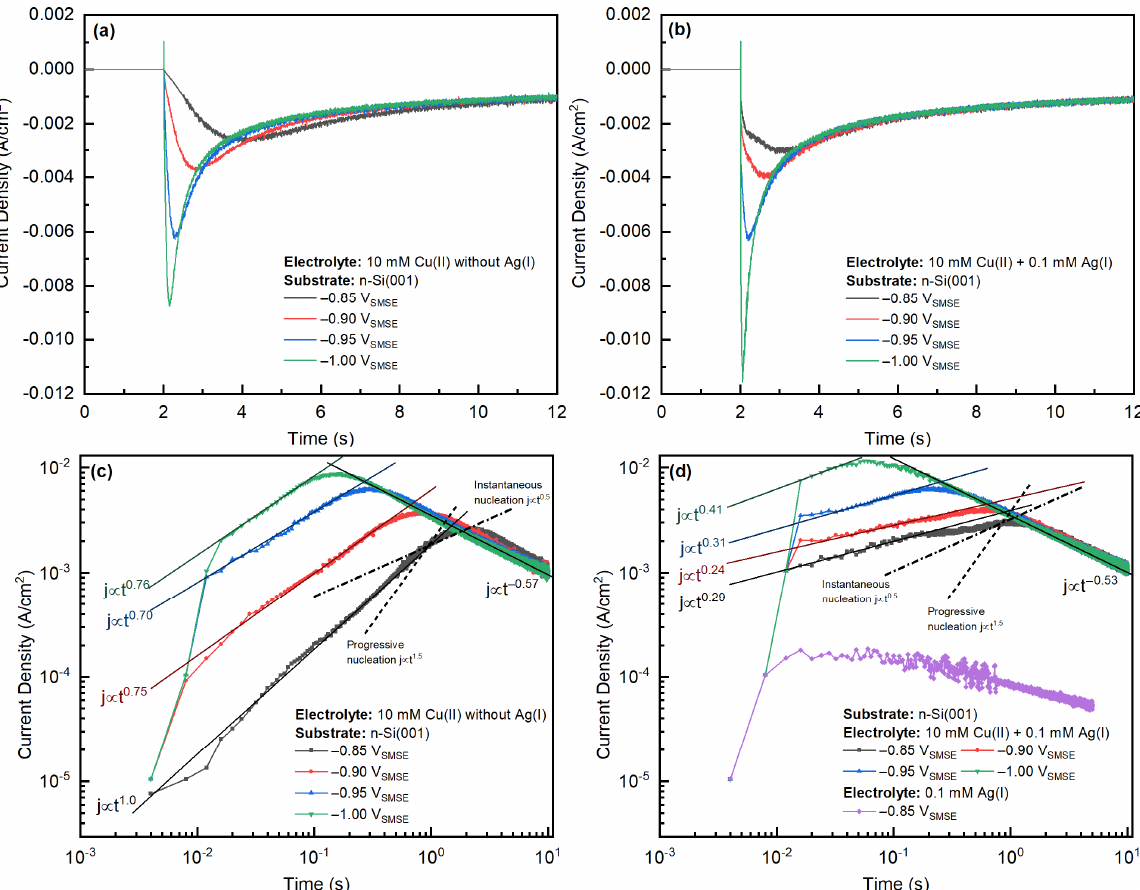
Figure 6. Potentiostatic transients and the fitting of transients from 10 mM CuSO 4 + 0.5 M H 2 SO 4 ( a , c ) without or ( b , d ) with the addition of 0.1 mM AgNO 3 based on classical model [35]. The peak time is roughly 4s and the peak current is roughly − 0.003 A/cm 2 .